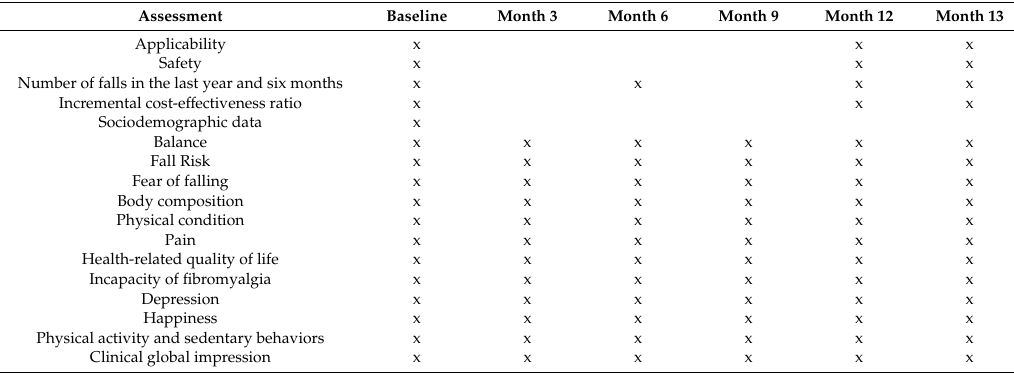
Table 2. Assessments schedule for both experimental and control